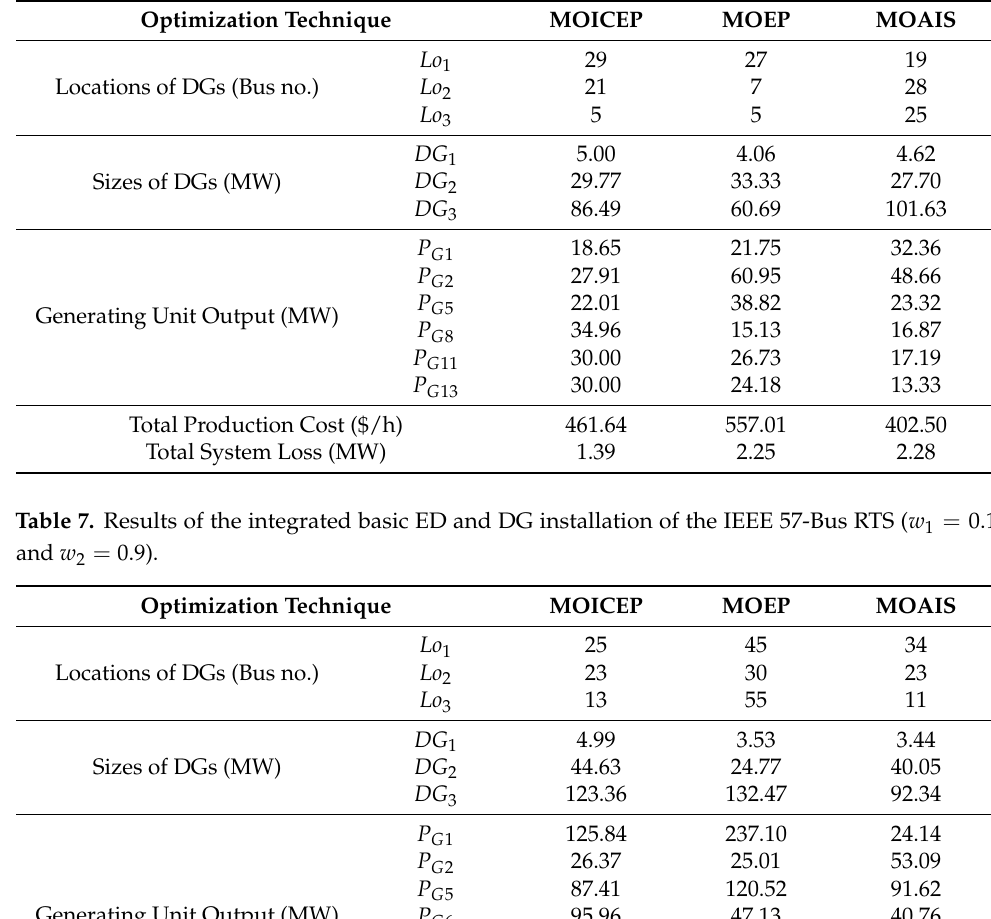
Table 6. Results of the integrated basic ED and DG installation of the IEEE 30-Bus RTS ( w 1 = 0.1 and w 2 = 0.9).